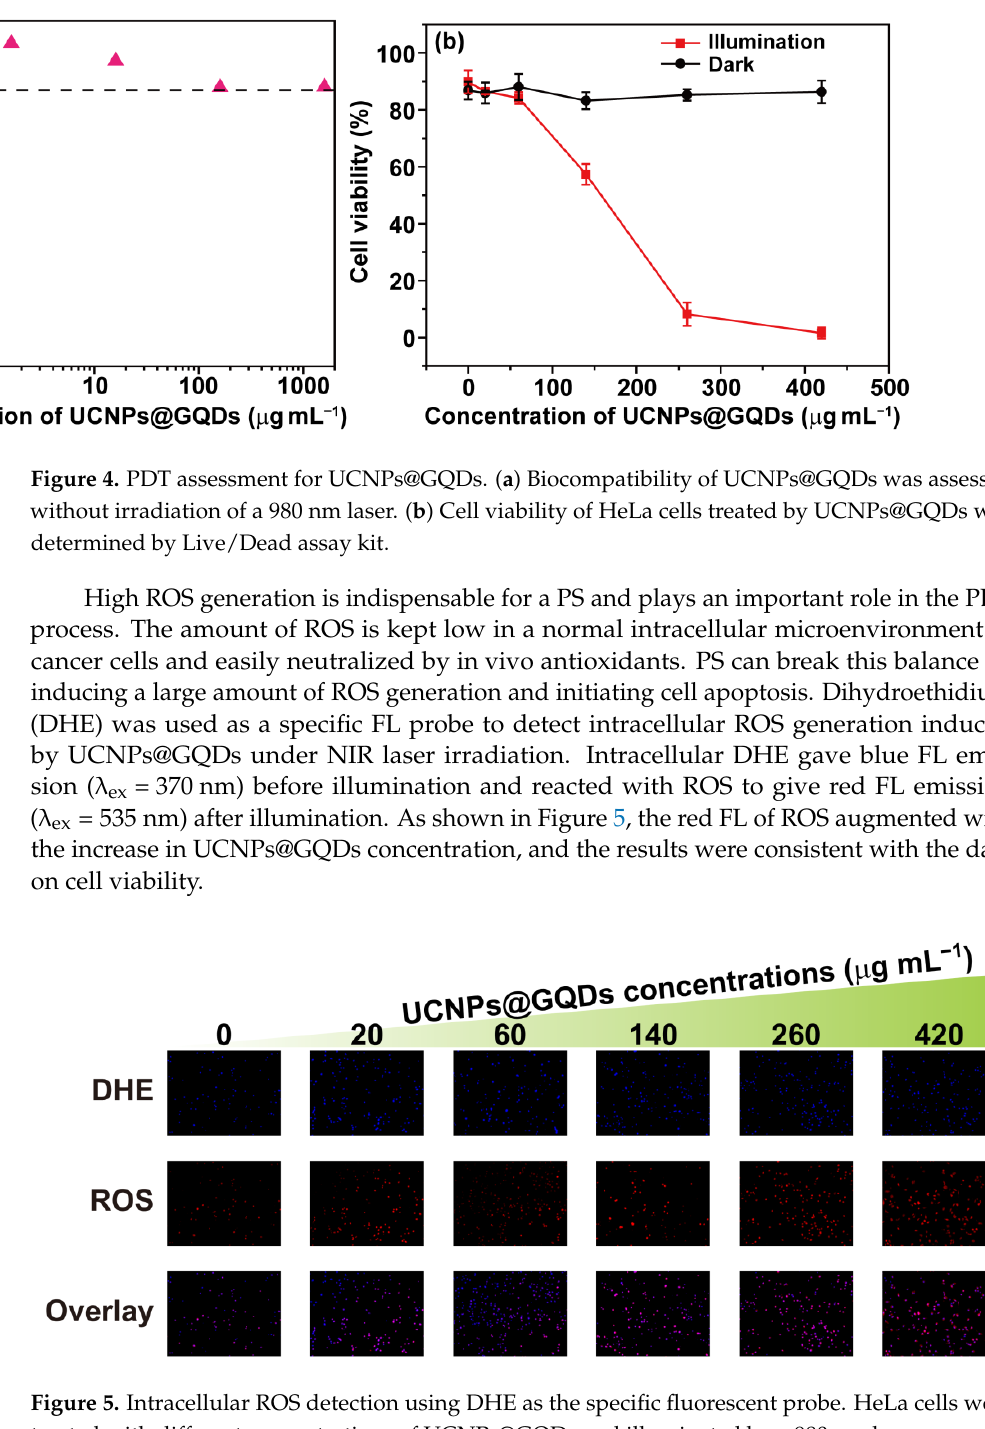
Figure 5. Intracellular ROS detection using DHE as the specific fluorescent probe. HeLa cells were treated with different concentrations of UCNPs@GQDs and illuminated by a 980 nm laser.